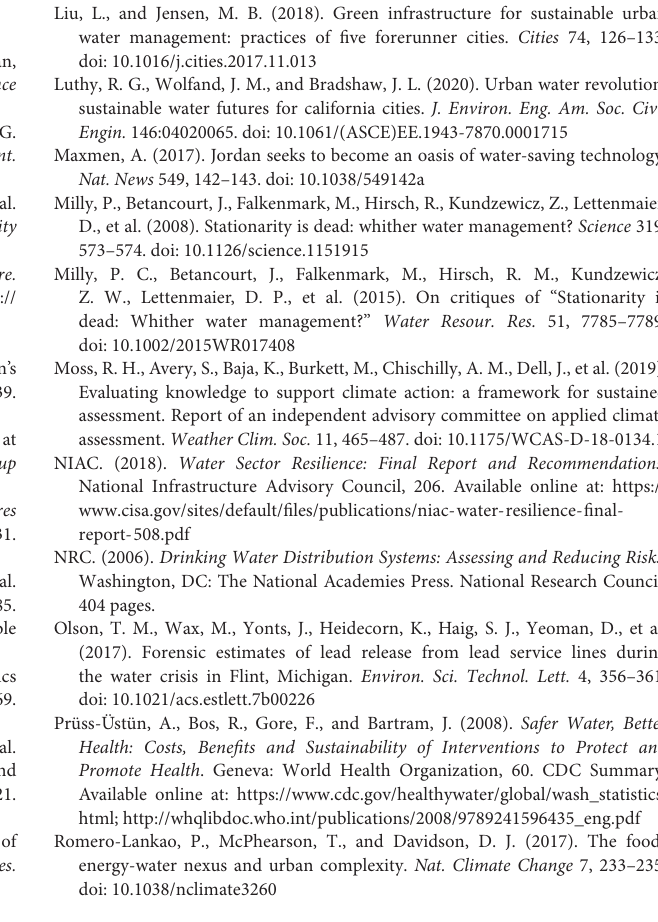
Figure 1 attempts to depict the essence of this grand